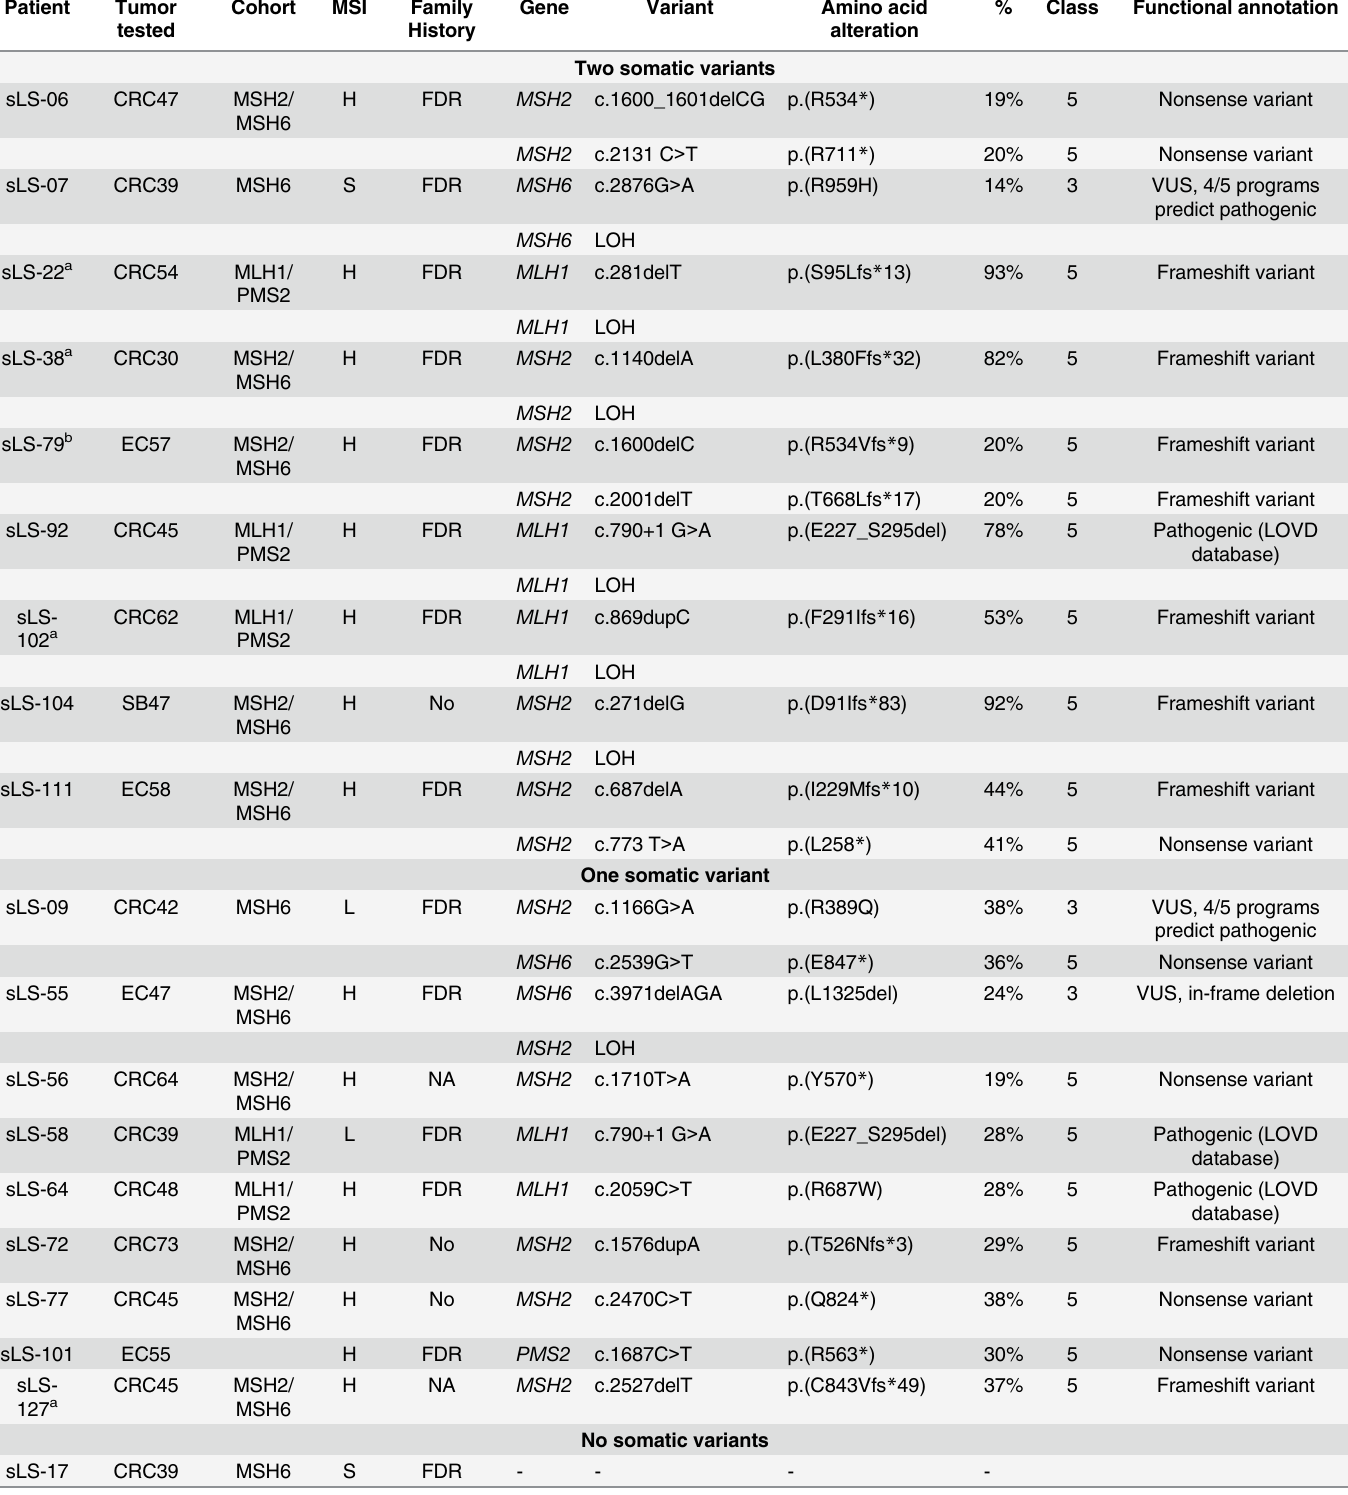
Table 4. Patients screened for somatic